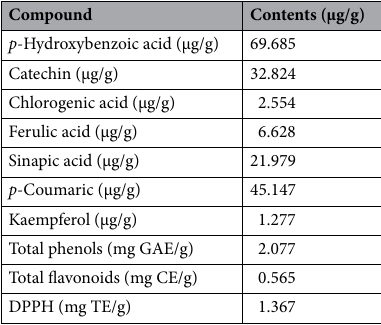
Table 1. Phenolic profile (μg/g), total phenols (mg GAE/g), Total flavonoids (mg CE/g) and antioxidant activity DPPH (mg TE/g) of black seeds (Nigella sativa). GAE gallic acid equivalents, CE catechin